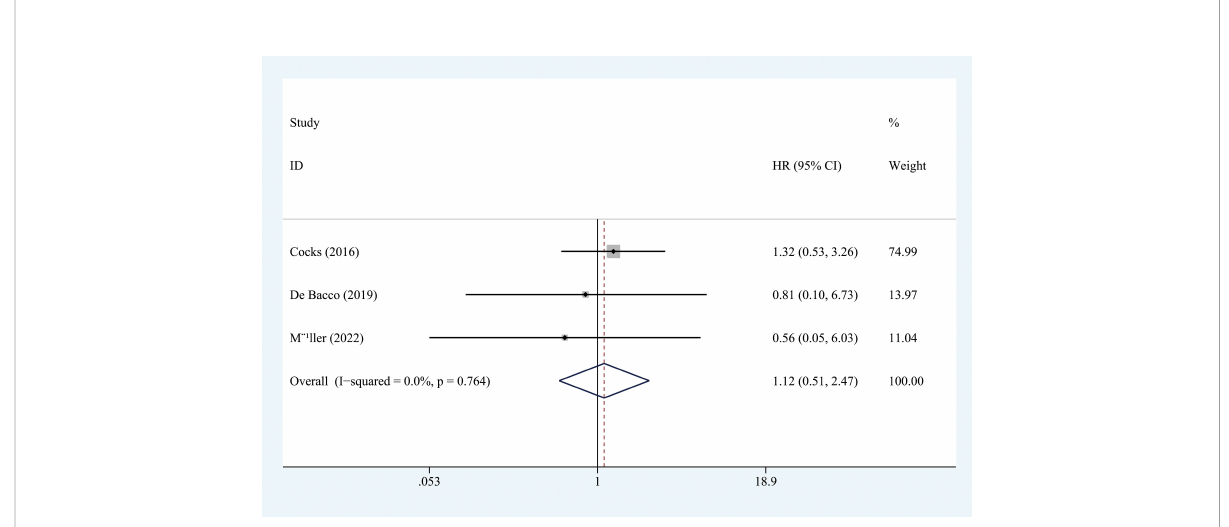
FIGURE 4 Prognostic value of PD-L1 for OS. OS, overall survival; HR, hazard ratio; CI, con fi dence